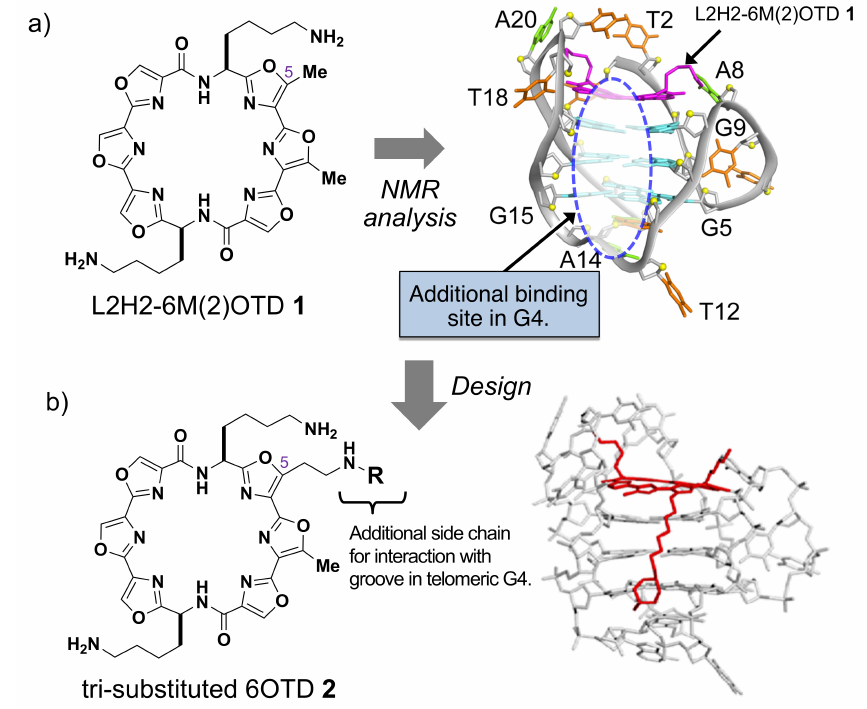
Figure 1. ( a ) Structure of L2H2-6M(2)OTD 1 and its interaction with telomeric G-quadruplex (G4), as elucidated by NMR analysis; ( b ) Structure of tri-substituted macrocyclic hexaoxazole (6OTD) 2 , and its possible interaction with telomeric